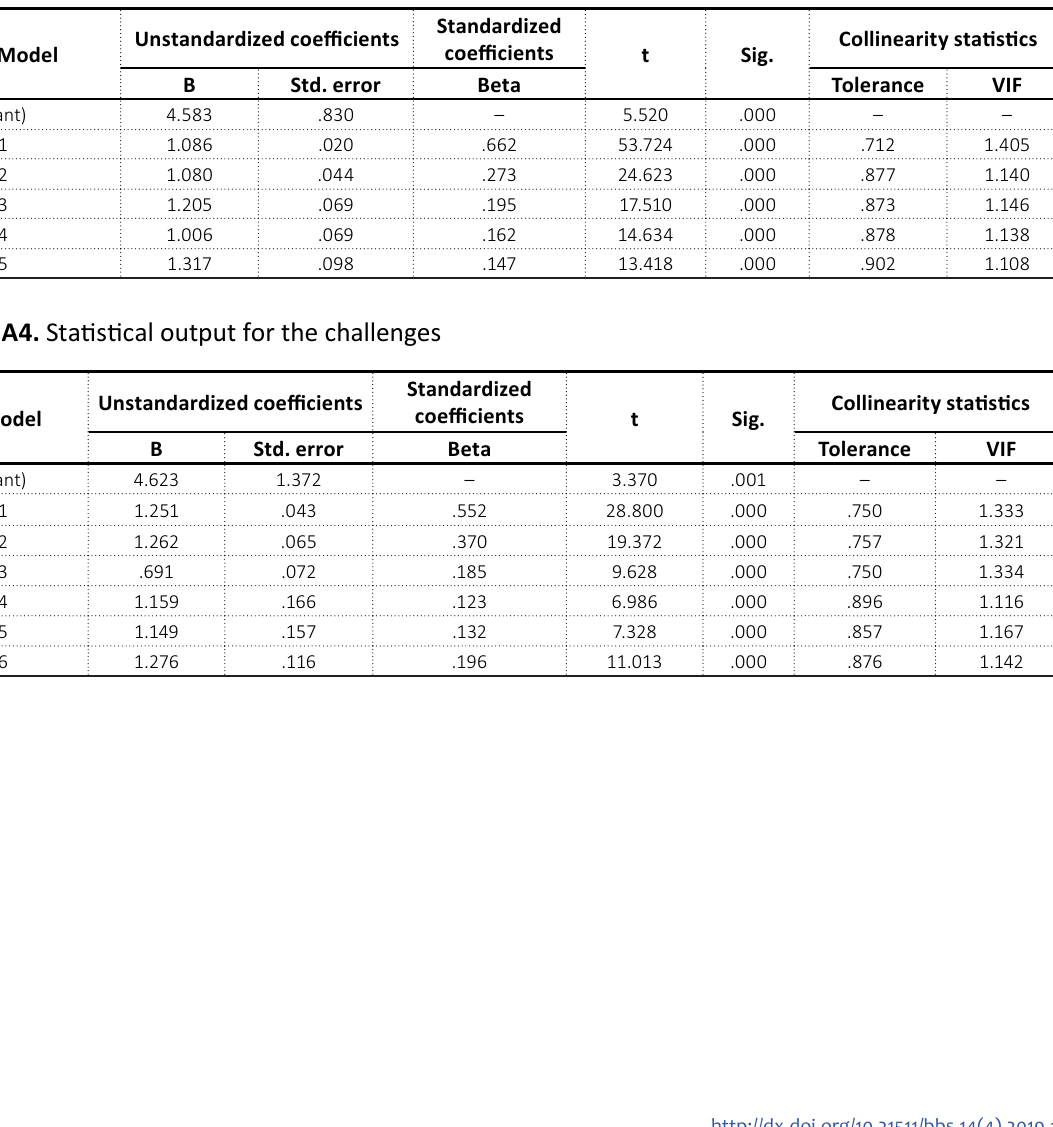
Table A3. Statistical output for the prospects Model